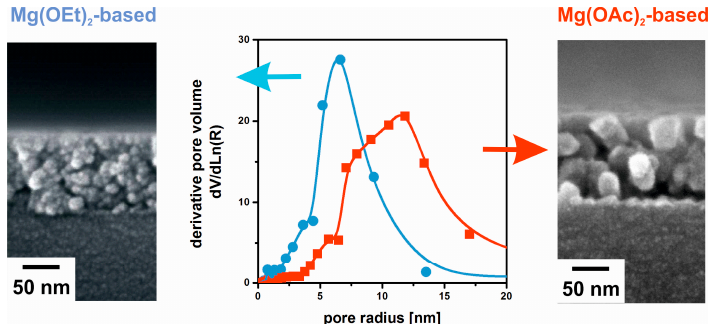
Figure 6. SEM cross-sectional images of two MgF 2 thin films based on Mg(OEt) 2 ( left ) and Mg(OAc) 2 ( right ). The pore radius distributions as determined by Ellipsometric Porosimetry are given in the middle . Based on [41].